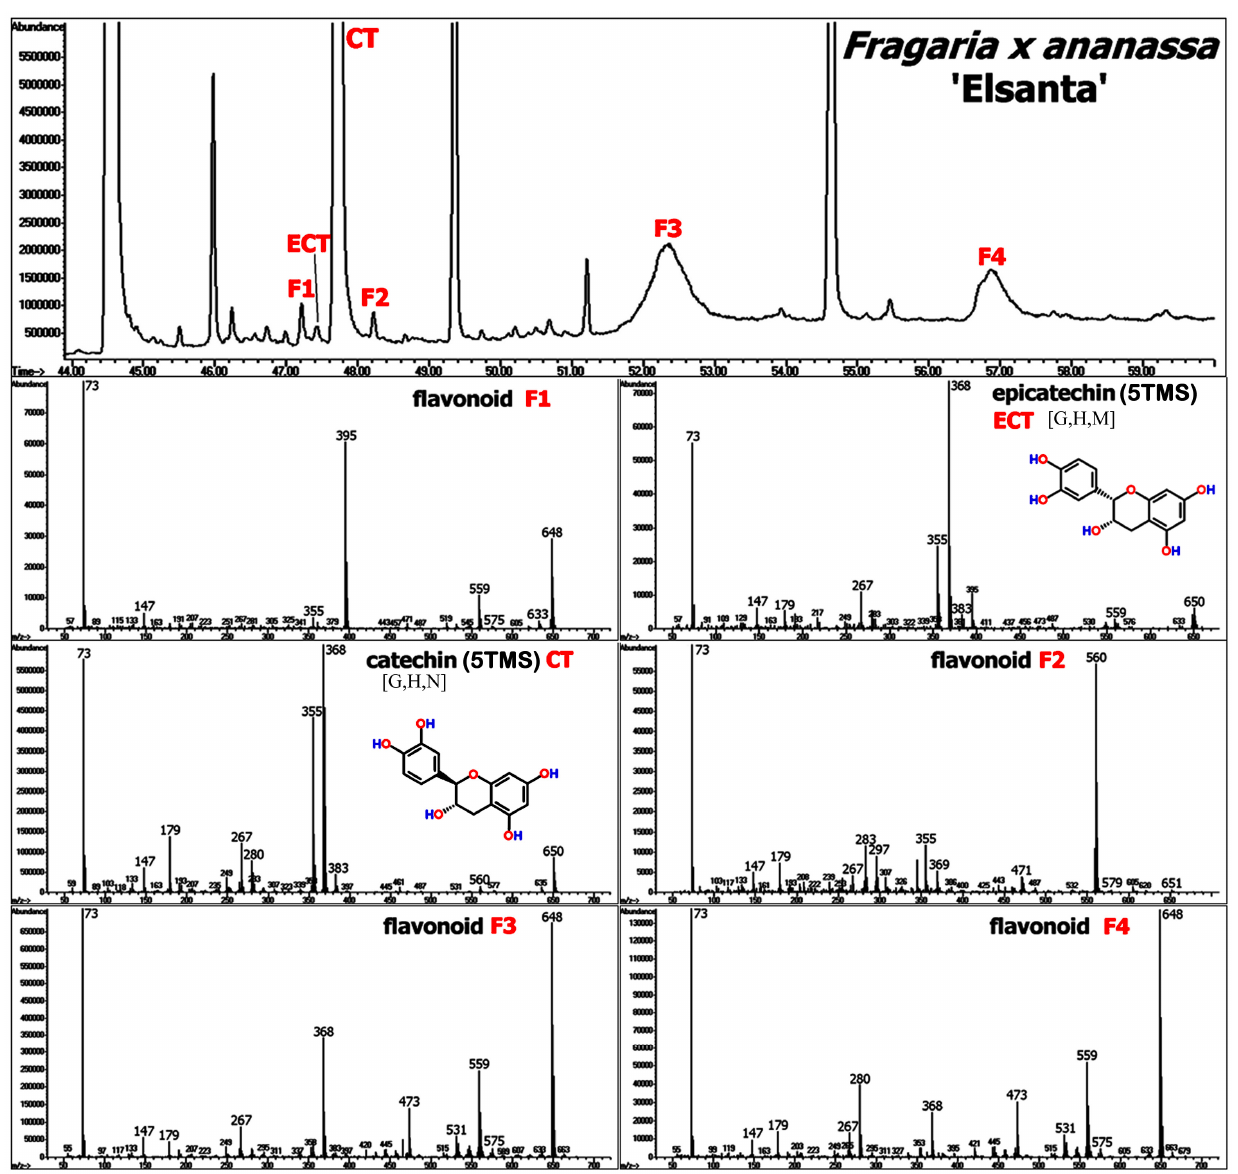
Figure 8. The upper figure shows a chromatogram cut from the analysis of a strawberry crown sample (vegetative tissue) of Fragaria x ananassa Duch. cv. “Elsanta”. The MS spectra of commonly found TMS derivatives of polyphenolic structures such as catechin (5TMS) (CT), epicatechin (5TMS) (ECT) and unidentified flavonoid structures (F1 to F4) are depicted in the figures below. MS spectra of CT and ECT can be found in the Golm Metabolome Database [G], Human Metabolome Database [H], MassBank [M], and/or NIST Chemistry WebBook